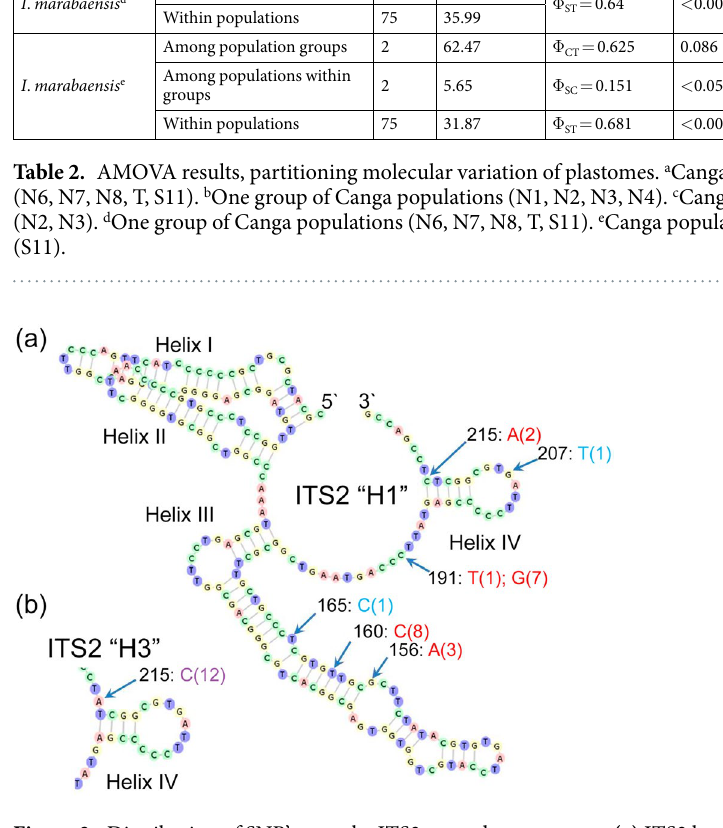
Figure 3. Distribution of SNP’s over the ITS2 secondary structure. (a) ITS2 haplotype “H1” and (b) the Helix IV of the folded ITS2 haplotype “H3”. Arrows point bases at which natural variation was observed. Numbers in black are the bases numbering from the 5 ′ end. The letters next to arrows are the alternative bases, i.e. SNP; bracketed numbers are instances among fourteen recorded haplotypes. SNP are colored in red, when a polymorphism is only found in I . cavalcantei ; in blue for I . marabaensis ; in purple, when shared between the